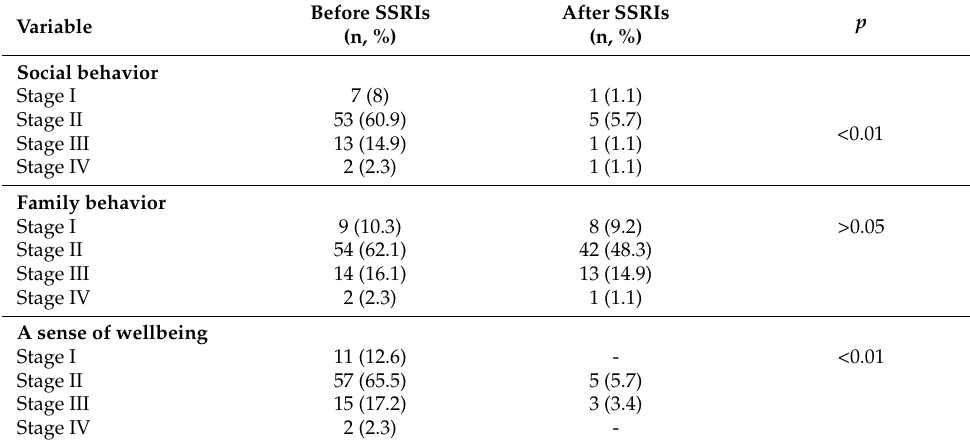
Table A3. Characteristics of psychosocial functioning (bad) according to the stage of disease (FEV1) before and after the use of